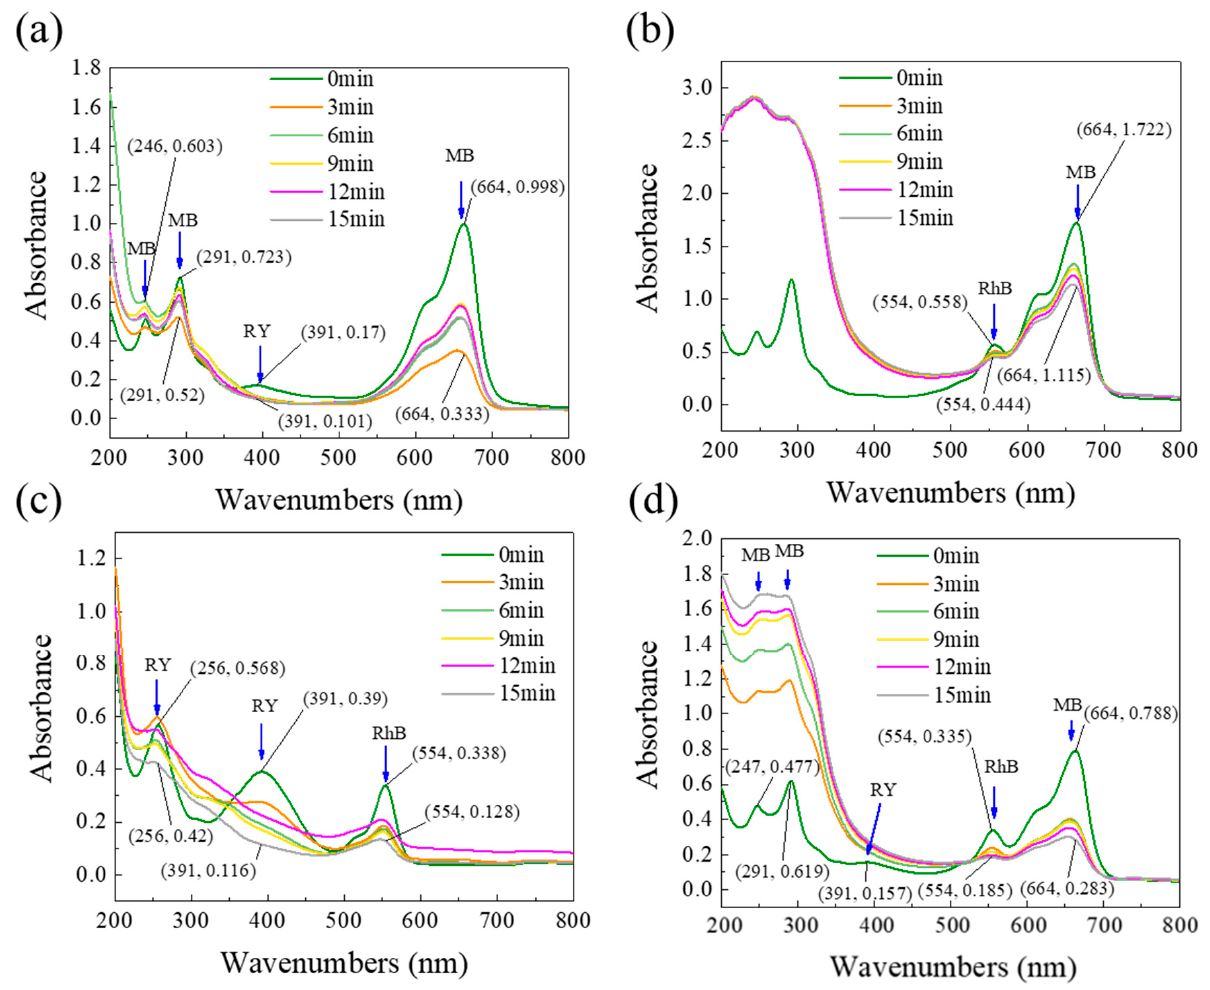
Figure 4. UV-Vis spectra of ( a ) RhB-RY, ( b ) RY-MB, ( c ) RhB-MB, and ( d ) RhB-RY-MB solution during the photocatalytic degradation